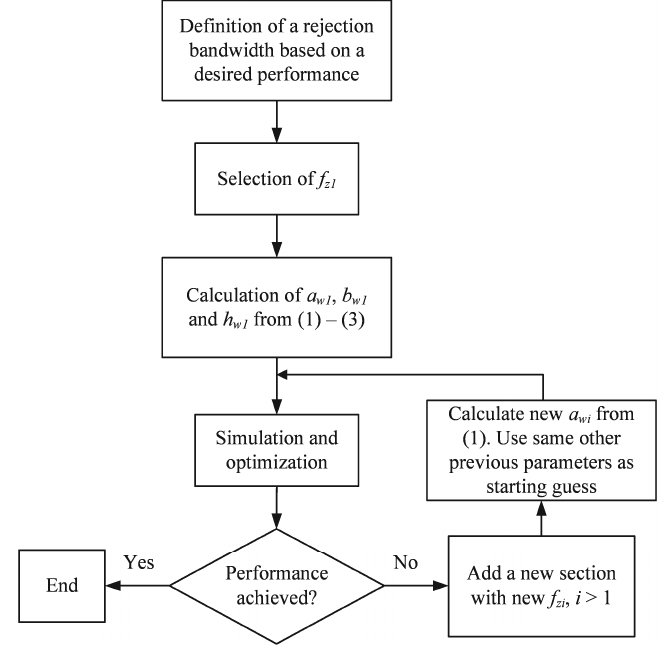
Figure 6. Summary of the filter synthesis procedure.